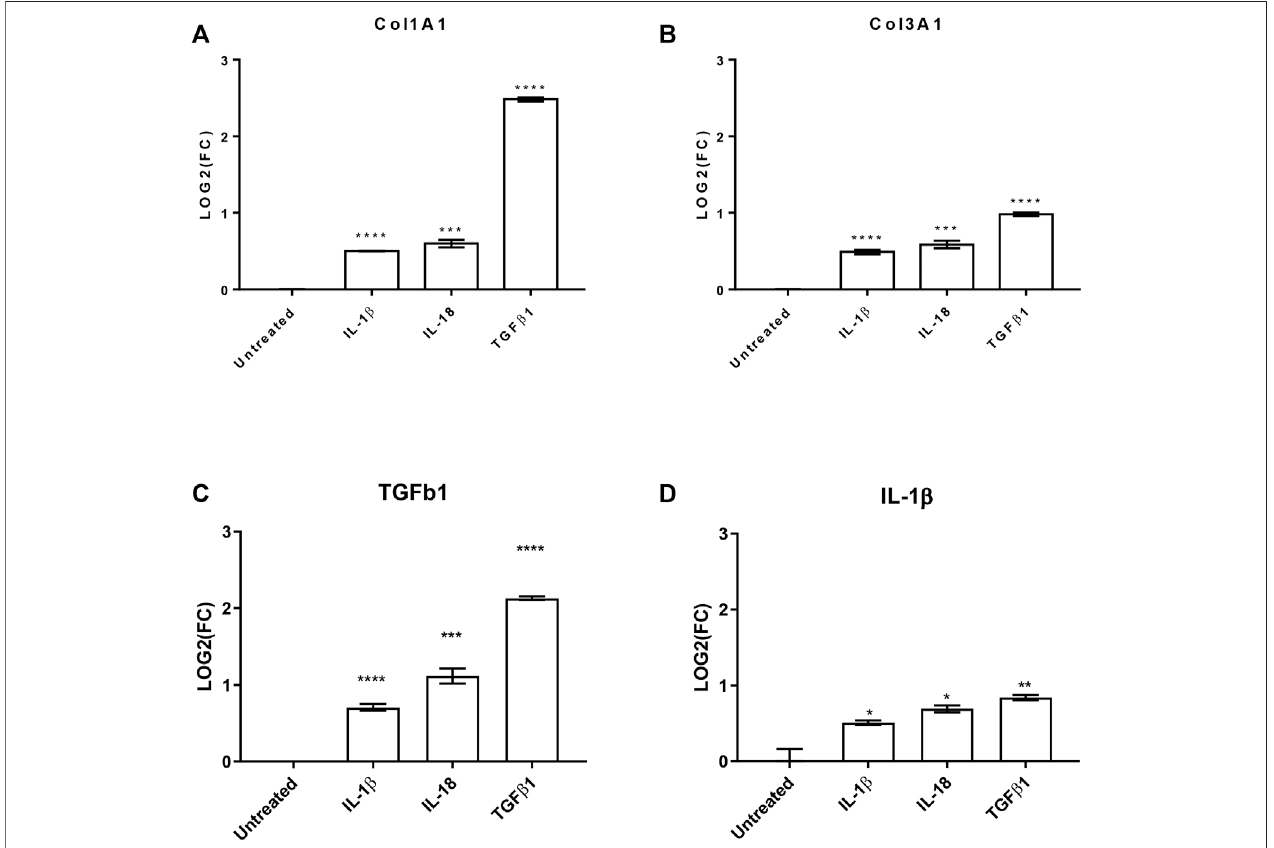
FIGURE3| IL-1 β andIL-18effectsonpro- fi broticandpro-in fl ammatorygenes.Bargraphsreportingtherelativegeneexpressionof (A) collagen1A1(Col1A1), (B) collagen 3A1 (Col3A1), (C) transforming growth factor β 1 (TGF β 1), and (D) interleukin 1 β (IL-1 β ) of human cardiac fi broblasts under IL-1 β , IL-18, and TGF β 1 (as positive control) treatments ( n = 3). Data are expressed by mean ± SEM. * p < 0.05; ** p < 0.01; *** p < 0.001; **** p < 0.0001 vs. untreated.